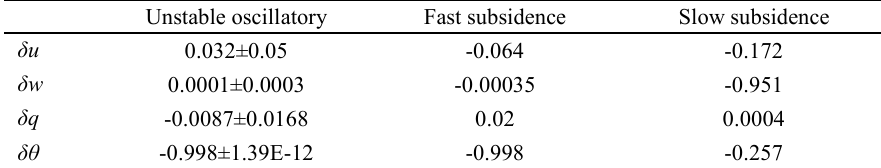
Table 2 Eigenvectors of the system matrix